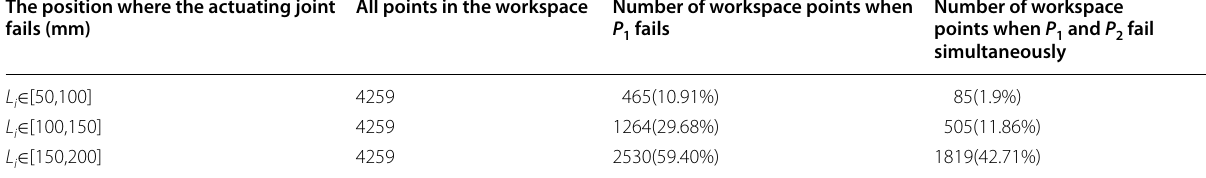
Table 3 The influence of the failure position of the actuating joint on the workspace The position where the actuating joint fails (mm)